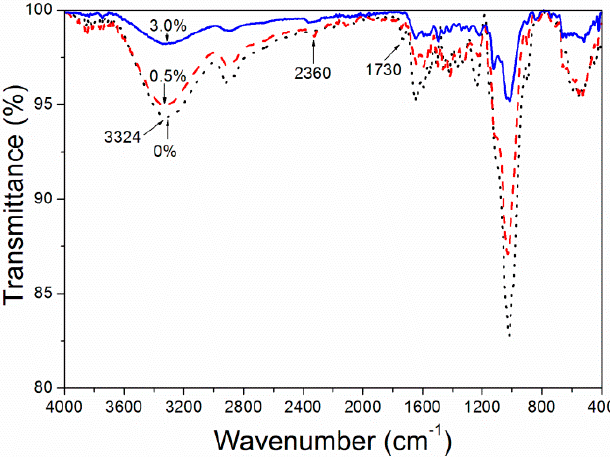
Figure 6. IR spectra of F. mandshurica veneer after dyeing with different concentrations of reactive black.